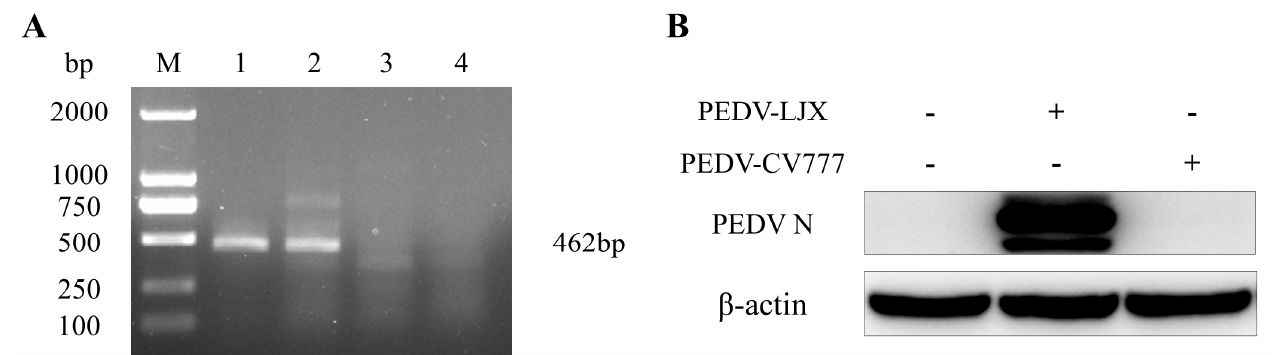
Figure 1. ( A ) M gene expression after infection of FHs 74 Int cells with different strains of PEDV. M: DL 2000 Marker; 1: PEDV positive control; 2: PEDV-LJX + FHs 74 Int; 3: PEDV-CV777 + FHs 74 Int; 4: FHs 74 Int. ( B ) N protein levels after infection with FHs 74 Int cells with different strains of PEDV. PEDV, porcine epidemic diarrhea virus; FHs 74 Int cells, human small intestine epithelial cells.